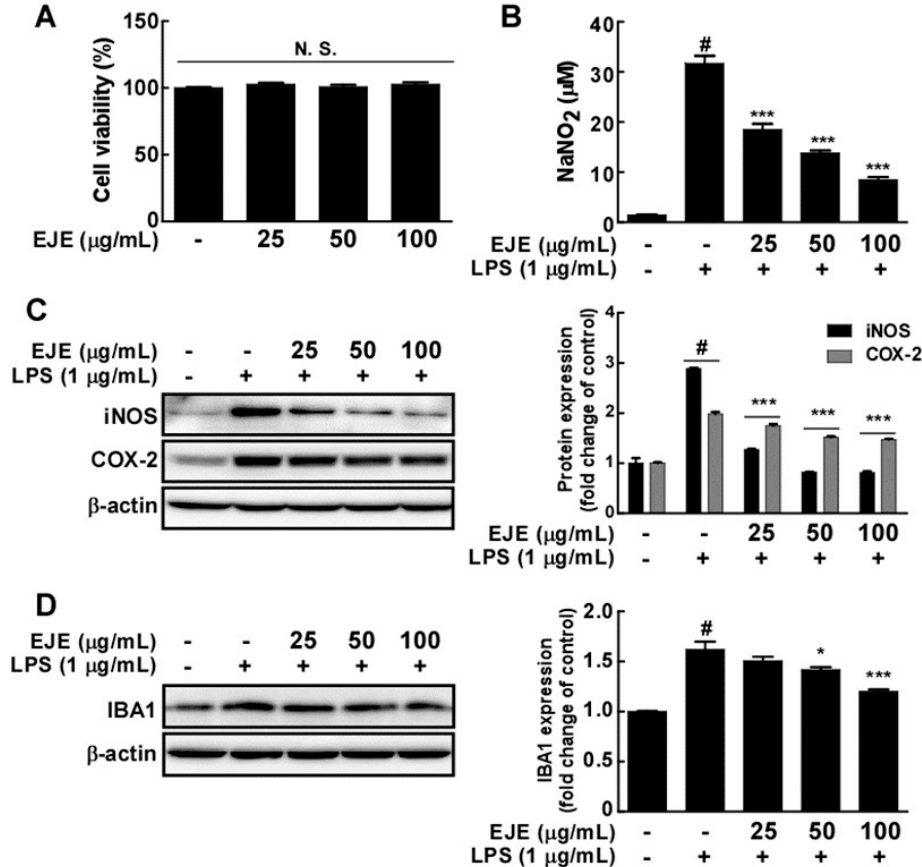
Figure 1. E ff ect of Erythronium japonicum extract (EJE) on lipopolysaccharide (LPS)-induced microglial activation. ( A ) EJE did not a ff ect cell viability in BV2 cells. Cell viability was measured using an MTS assay, as indicated in Materials and Methods. ( B ) EJE inhibited LPS-induced nitric oxide (NO) production in BV2 cells. For the Griess assay, Griess reagents were co-incubated with LPS and EJE-treated culture mediums and measured with a spectrophotometer plate reader, as described in Materials and Methods. ( C ) EJE inhibited LPS-induced inducible nitric oxide synthase (iNOS) and cyclooxygenase-2 (COX-2) expression in BV2 cells. The expression levels of iNOS, COX-2 and β -actin were determined by Western blot assays. ( D ) EJE inhibited LPS-induced ionized calcium-binding adapter molecule 1 (IBA-1) expression in BV2 cells. Expression was detected by Western blotting with a specific antibody. Hash symbols (#) indicate a significant di ff erence ( p < 0.001) between the control group and the group exposed to LPS alone; asterisks (* and ***) indicate significant differences ( p < 0.05